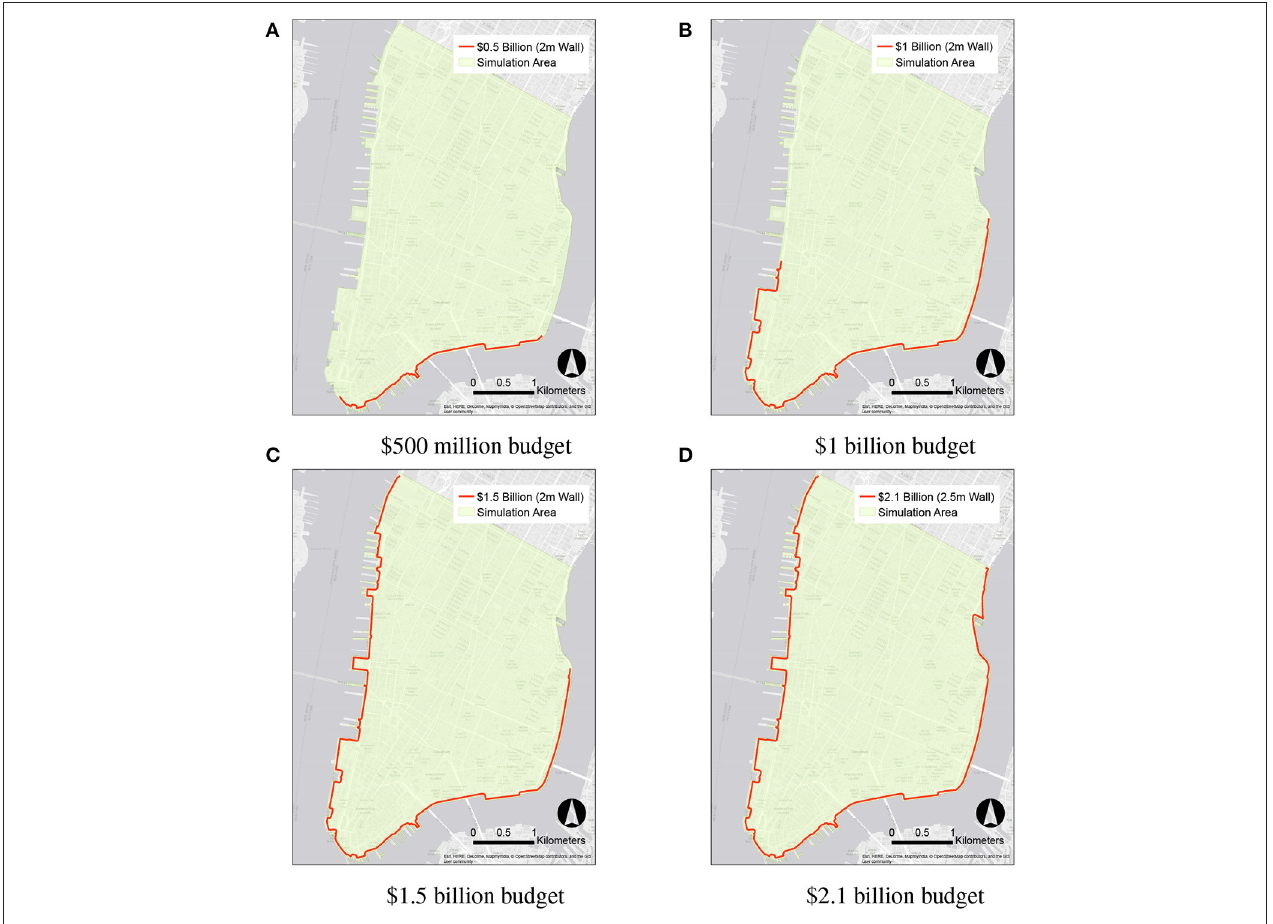
FIGURE 10 | Optimal protective seawall measures corresponding to four different prescribed budget levels. (A) $500 million budget, (B) $1 billion budget, (C) $1.5 billion budget, (D) $2.1 billion budget.